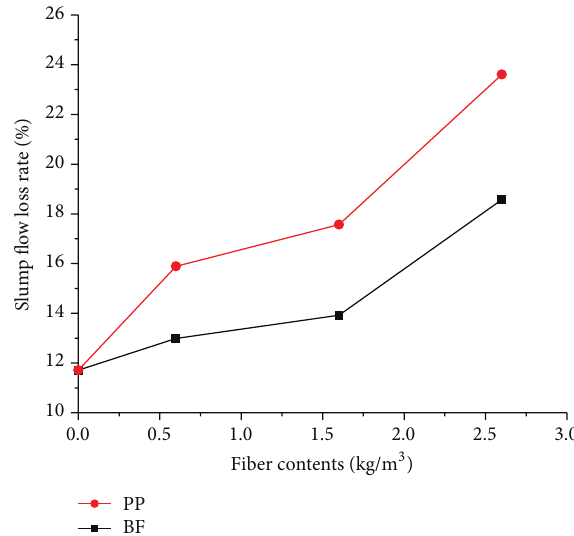
Figure 3: The effect of the contents of PP fiber and BF on the slump flow loss rate (after 2 h) of the mortar.